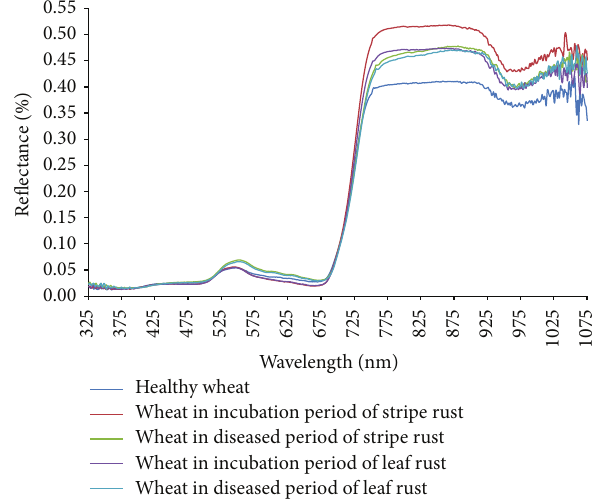
Figure 1: The canopy spectra of different categories of